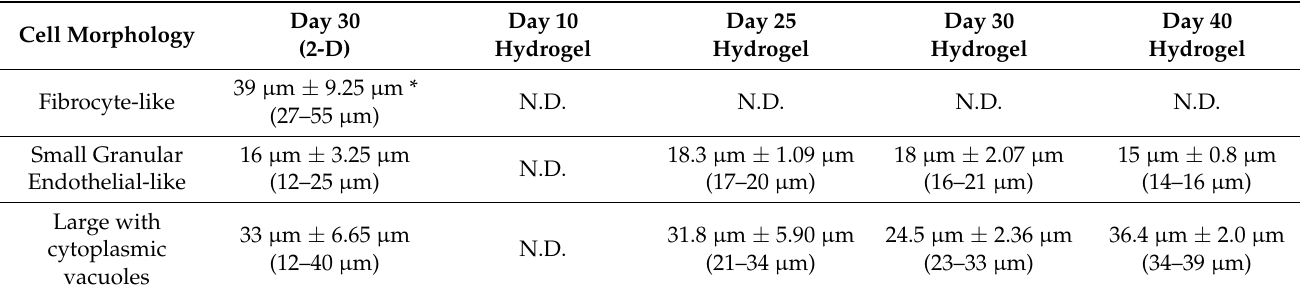
Table 2. Measurements for morphologies of BmVIII-SCC cells in 2-D monolayer and 3-D culture with hydrogel matrix.